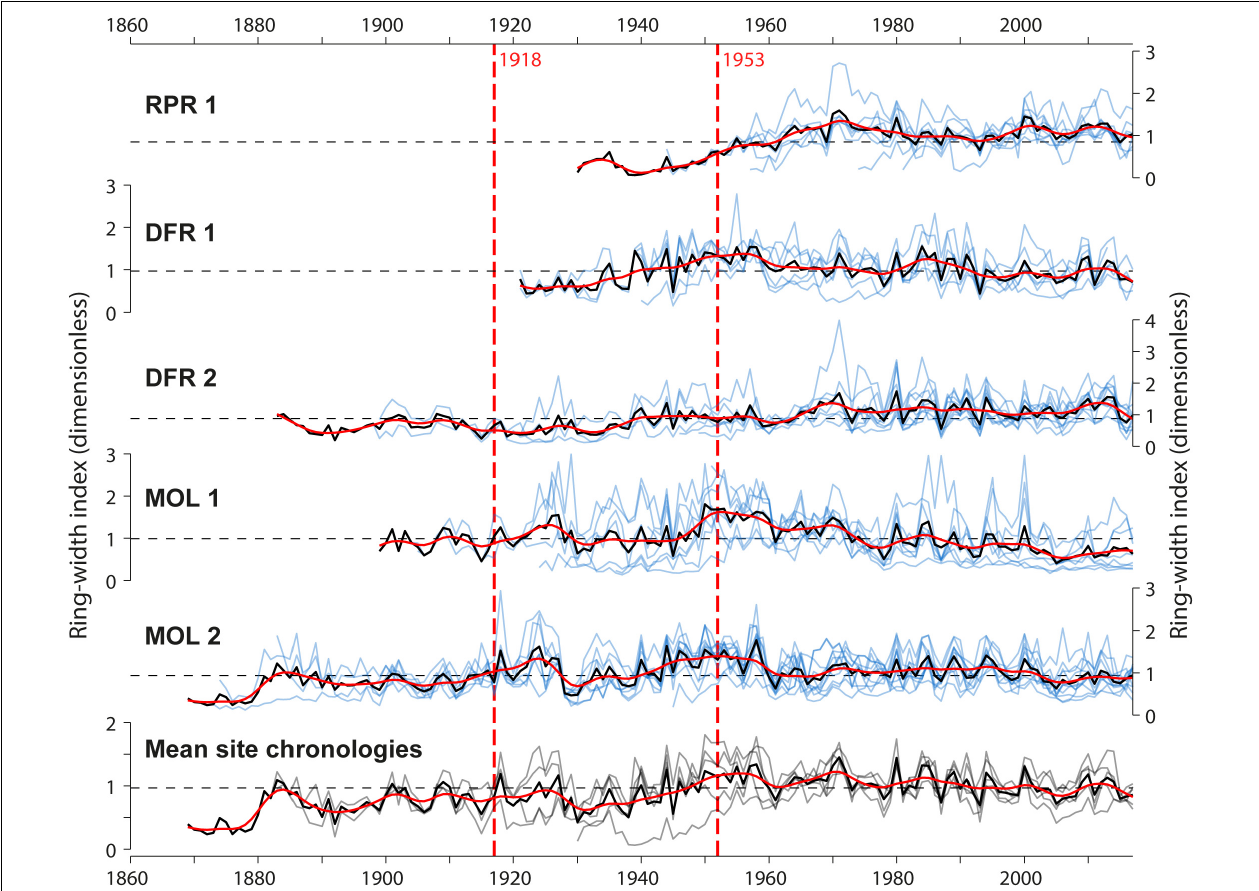
FIGURE 5 | Standardized tree-ring width series (pale blue line) and mean site chronologies (dark black lines), and comparison of mean site chronologies among the five sites. Vertical red dashed lines indicate dates of construction of the first and second Monteith dam. The red curves are 10-year spline functions and depict decadal variations in the mean radial tree growth at each